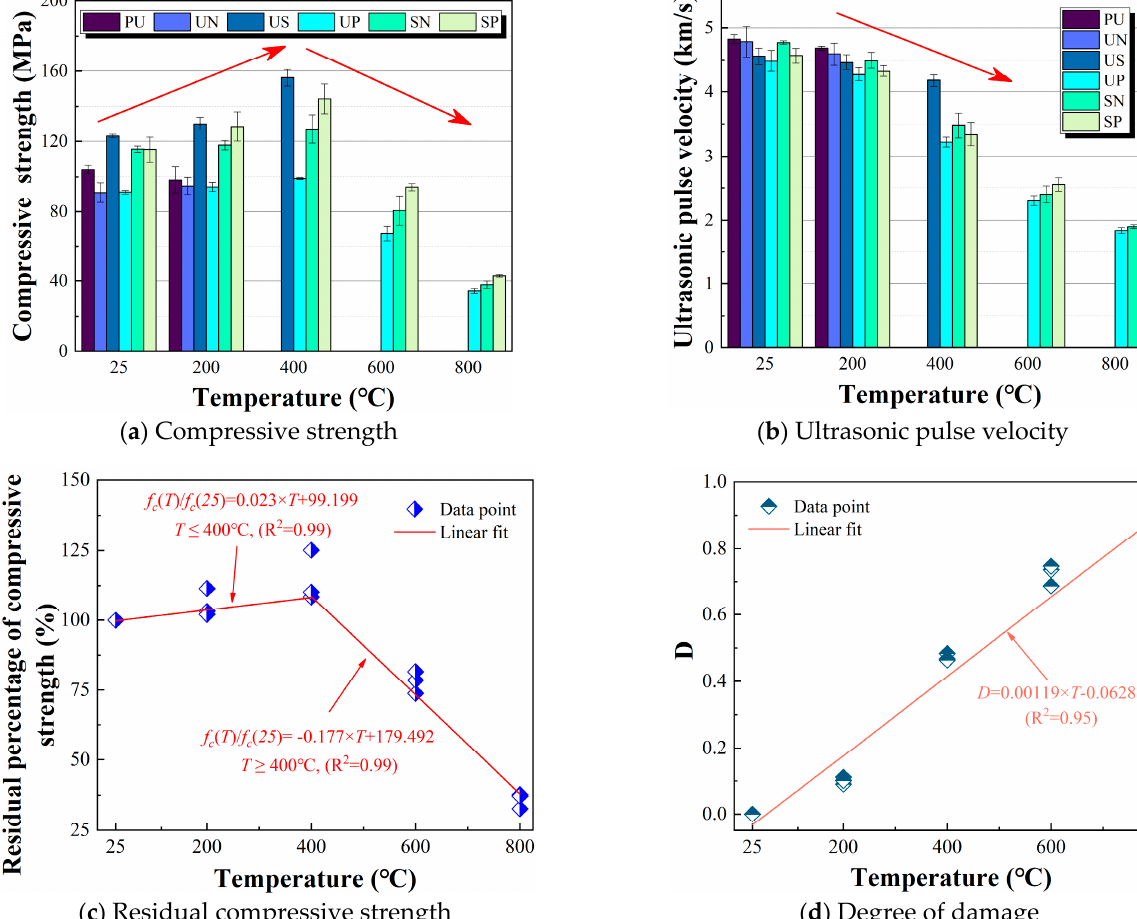
Figure 7. Mechanical properties of UHPC after exposure to high